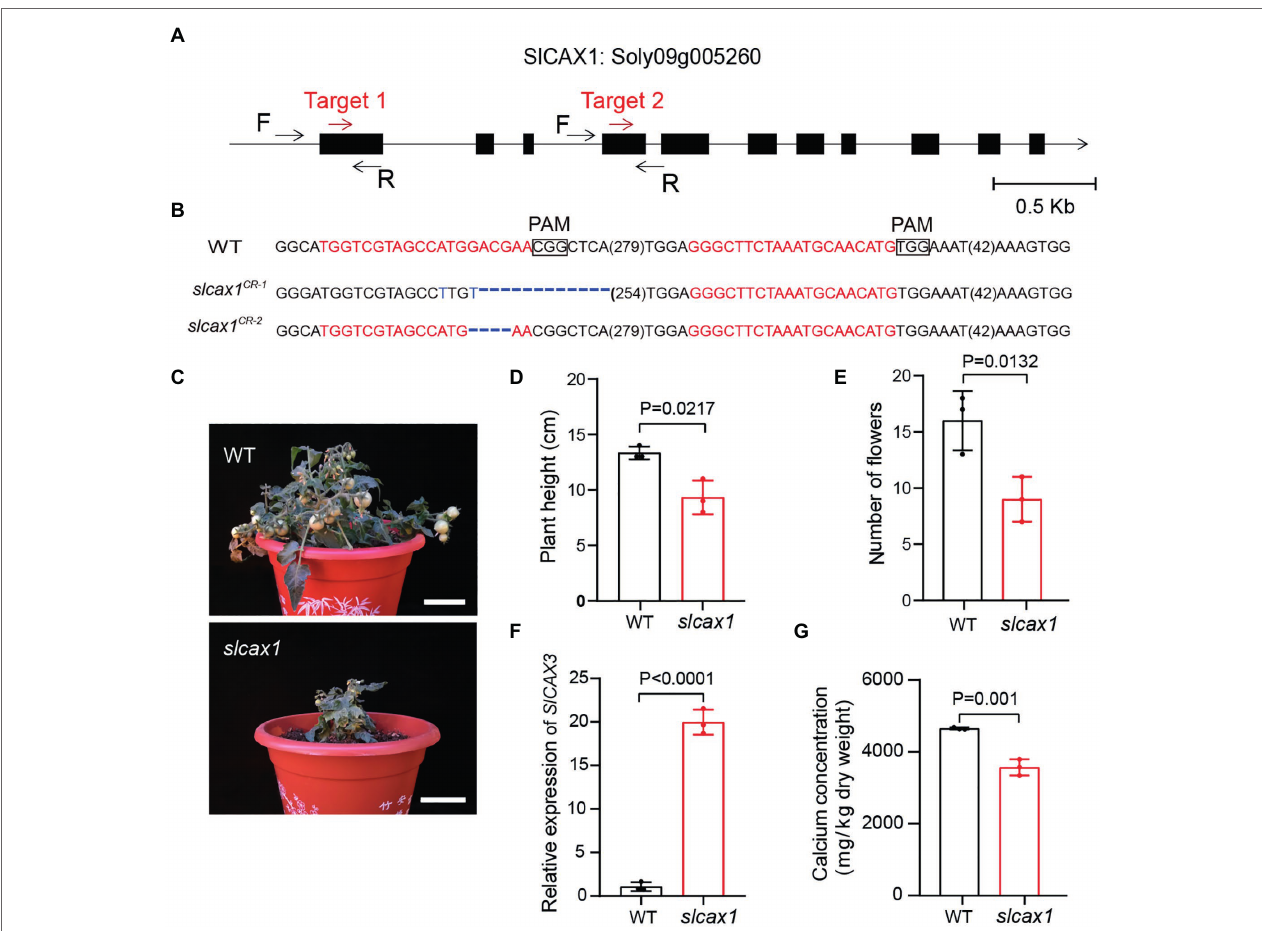
FIGURE 3 | CRISPR/Cas9-engineered mutations of SlCAX1 resulted in low Ca 2+ concentrations in tomatoes. (A) The first exon of SlCAX1 was targeted by CRISPR- Cas9 using two single guide RNAs (sgRNA; target 1 and target 2; red arrows). Black arrows indicate forward (F) and reverse (R) primers used for PCR genotyping and sequencing. (B) Sequences of slcax1 alleles were identified from two independent T1 transgenic plants. sgRNA targets and protospacer adjacent motif sequences are in red and bold font, respectively; deletions are indicated by blue dashes; and base mutations are shown in blue. The sequence gap length is shown in parentheses. (C) Phenotypes of the wild type and slcax1 mutants. (D) Plant height of wild type and slcax1 mutants grown for 2 months. (E) The number of flowers of wild type and slcax1 mutants. The pictures, plant height, and flower number data were collected from 2-month-old plants. (F) Analysis of SlCAX3 expression by RT-qPCR. Wild-type and slcax1 mutant leaves were harvested 2 weeks after germination for RNA extraction from three biological replicates. (G) Shoot calcium content in the wild type and slcax1 mutants. The wild type and mutants were grown on MS medium for 1 month, and then the shoots were harvested for calcium content measurement ( n = 3). The Student’s t -test was used to analyze the data for (D-G) . Error bars represent standard error of the